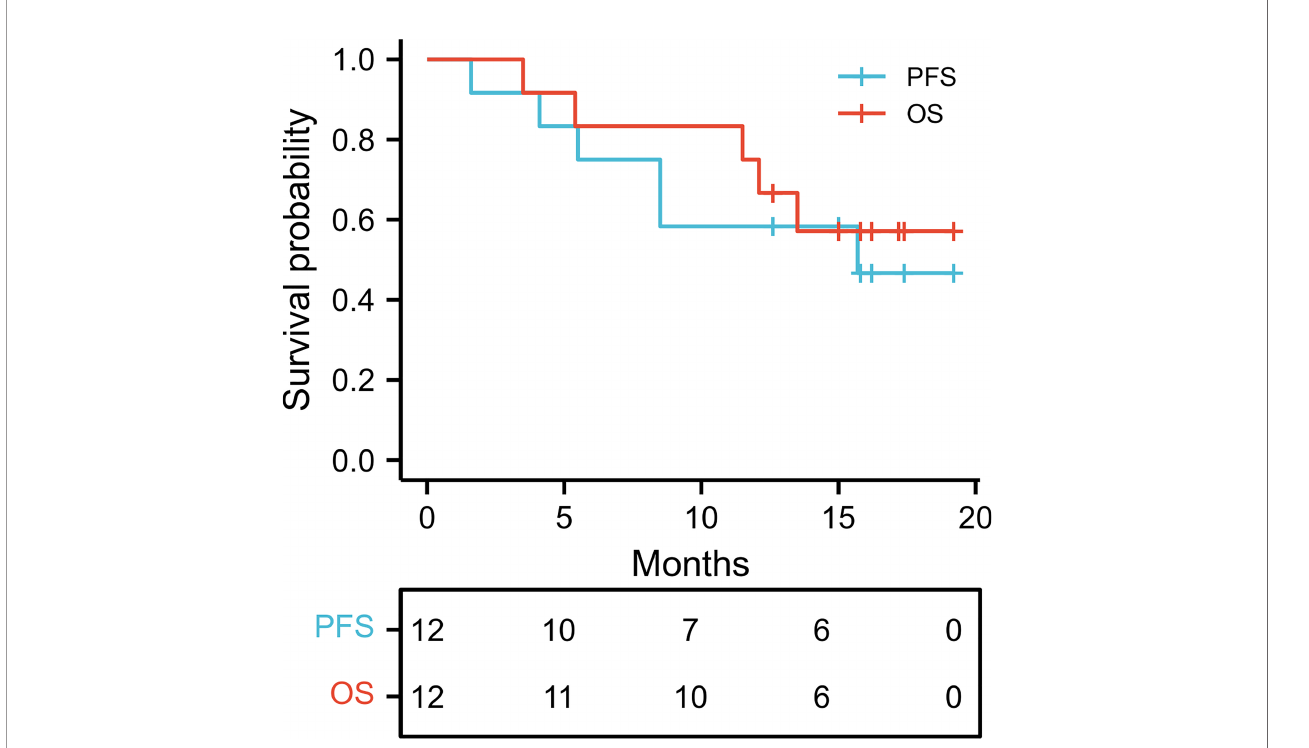
FIGURE 1 | Kaplan – Meier curves of PFS and OS. OS, Overall survival; PFS, progression-free survival.